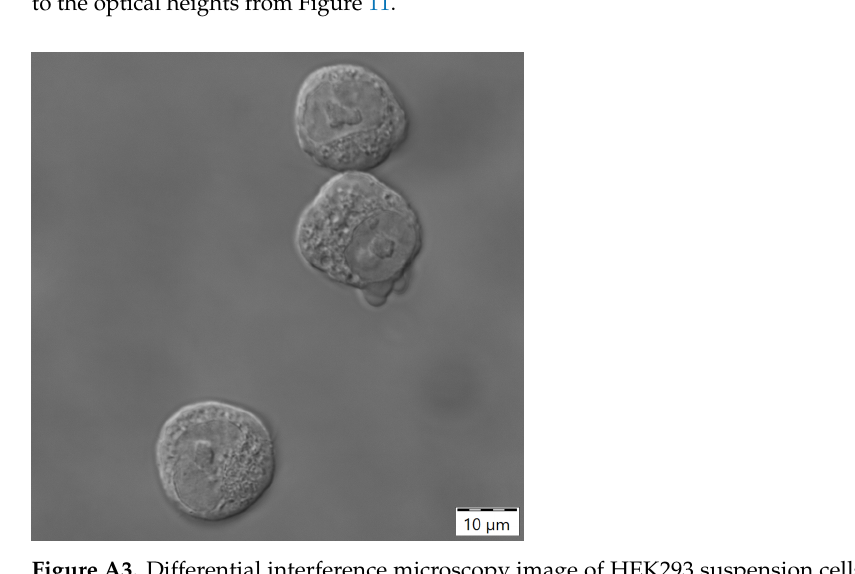
Figure A2. Phase-shift microscopy images from the iLine F analyser (scale bars are 80µm). The images (only one focal plane is shown here) serve as the basis for determining the optical height. The image series shows different times of Minifors 2 cultivation ( N = 180rpm, V = 4L) and corresponds to the optical heights from Figure 11.